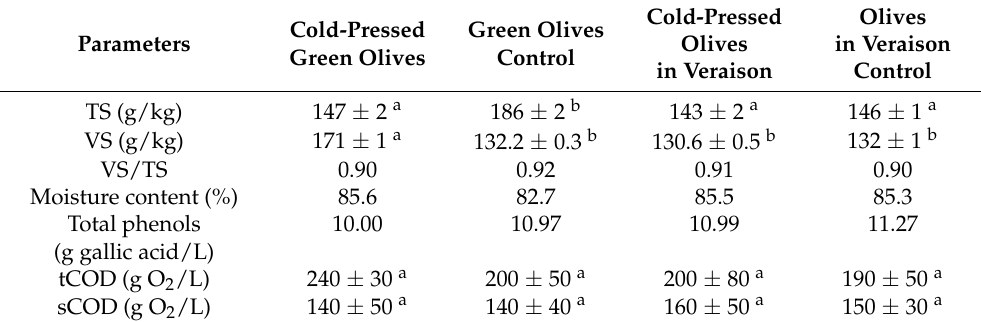
Table 1. Principal characteristics of the four residues (mixtures of the wastewaters and solid wastes) subjected to AD experiments. Values represent means ± standard deviations. Different superscripted letters (a, b) mean values are significantly different. Green Olives Olives Green Olives